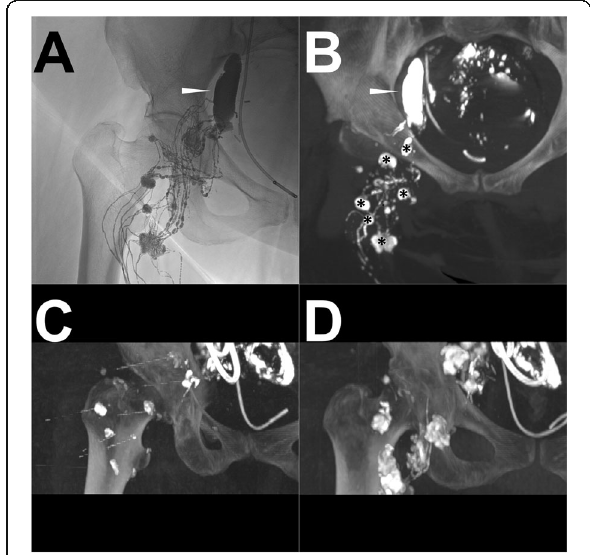
Fig. 8 A patient underwent a TNE procedure after post-LAG CT. Note: The conventional iodized oil-based LAG shows the obvious extravasation (white arrowhead) from multiple afferent LVs and LNs in the right pelvis ( a ). One (1) hour later, the post-LAG CT ( b ) was sequentially performed which shows similar findings (white arrowhead) and identifies seven definite afferent LNs (*). The TNE was carried out with a CT-controlled percutaneous puncture of seven afferent LNs ( c ). After the embolization with the histoacryl/ lipiodol mixture (1:1), the optimal distribution of the histoacryl/ lipiodol mixture in afferent LNs and LVs is observed ( d ). Abbreviations: TNE – trans-afferent nodal embolization;